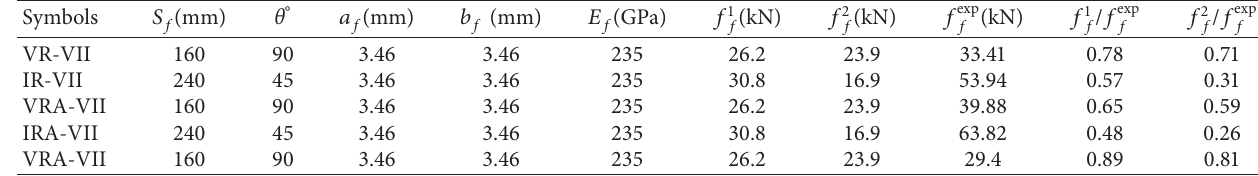
Table 5: Comparison between experimental results [112] and analytical